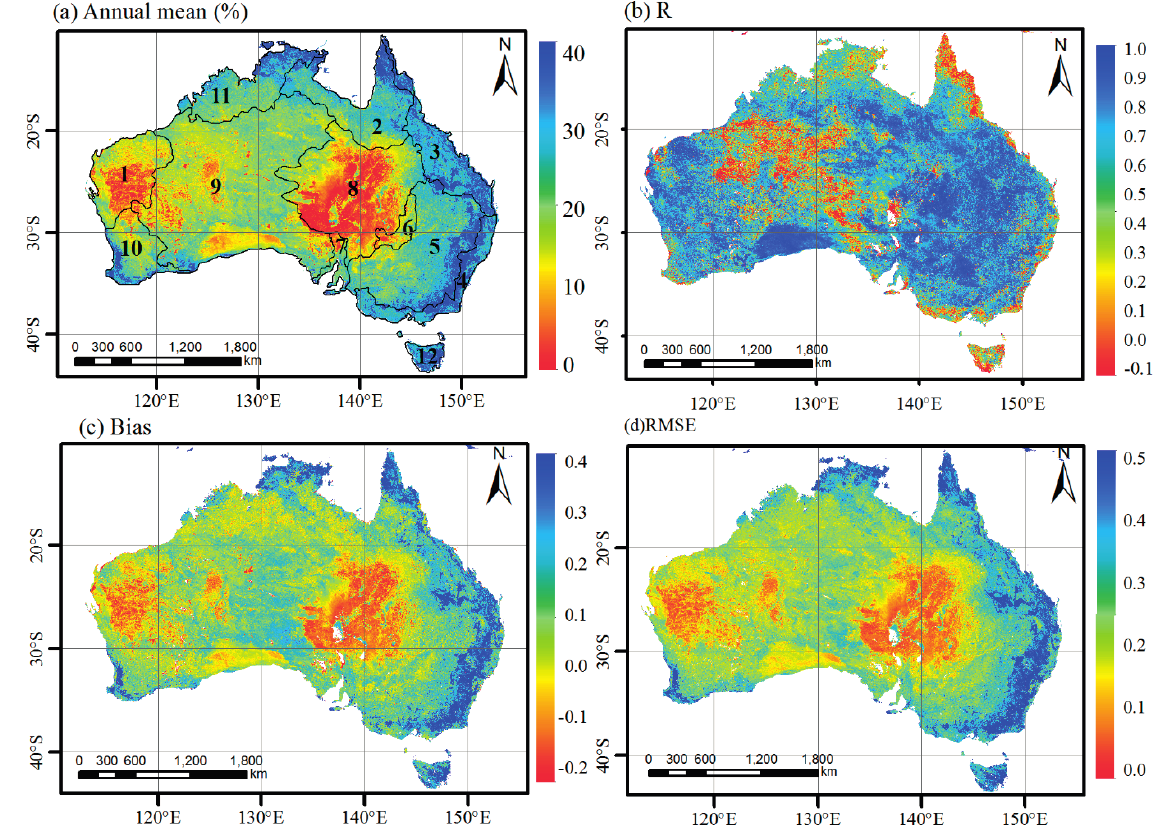
Figure 2. ( a ): Annual mean of the Australian MODIS FVC for the period 2000–2012. ( b – d ): the R, bias and RMSE between the GEOV1 FVC and the Australian MODIS FVC for the period 2000–2012. Drainage divisions across Australia: North-East Queensland Coast (3), South-East Australian coast (4), Tasmania (12), Murray-Darling Basin (5), Western Australia coast (1,10), Northern Australia (2, 11), Central Australia (6, 7, 8), and Western Plateau